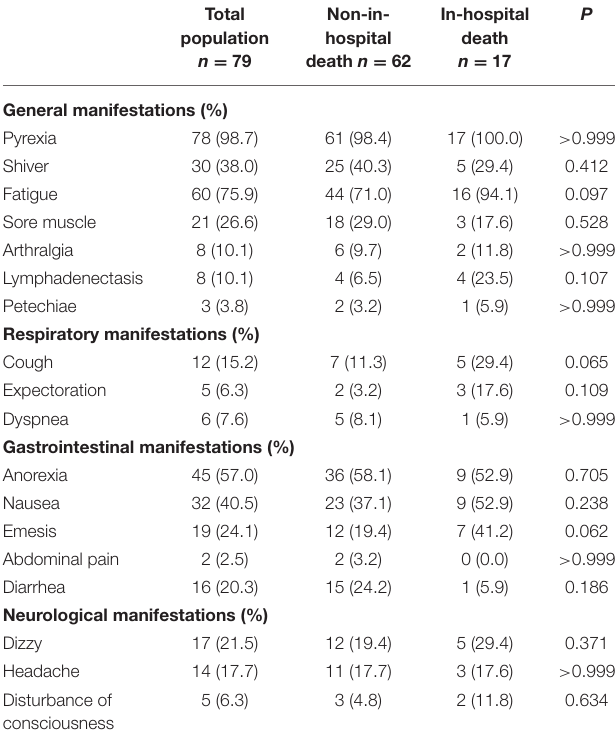
TABLE 2 | Baseline clinical manifestations of the study